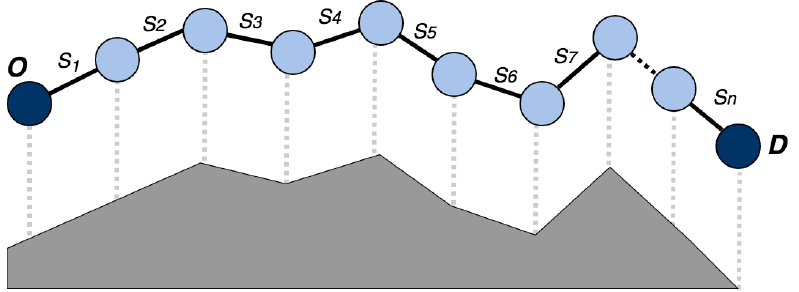
Figure 5. Example of route segmentation. The bottom side and the upper side of the route is segmented according to its profile.